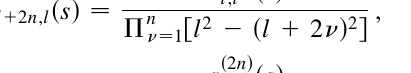
FIG. 1. (Color) Center tunes as a function of aperture. The fringe field shape is given by the default Enge coefficients.